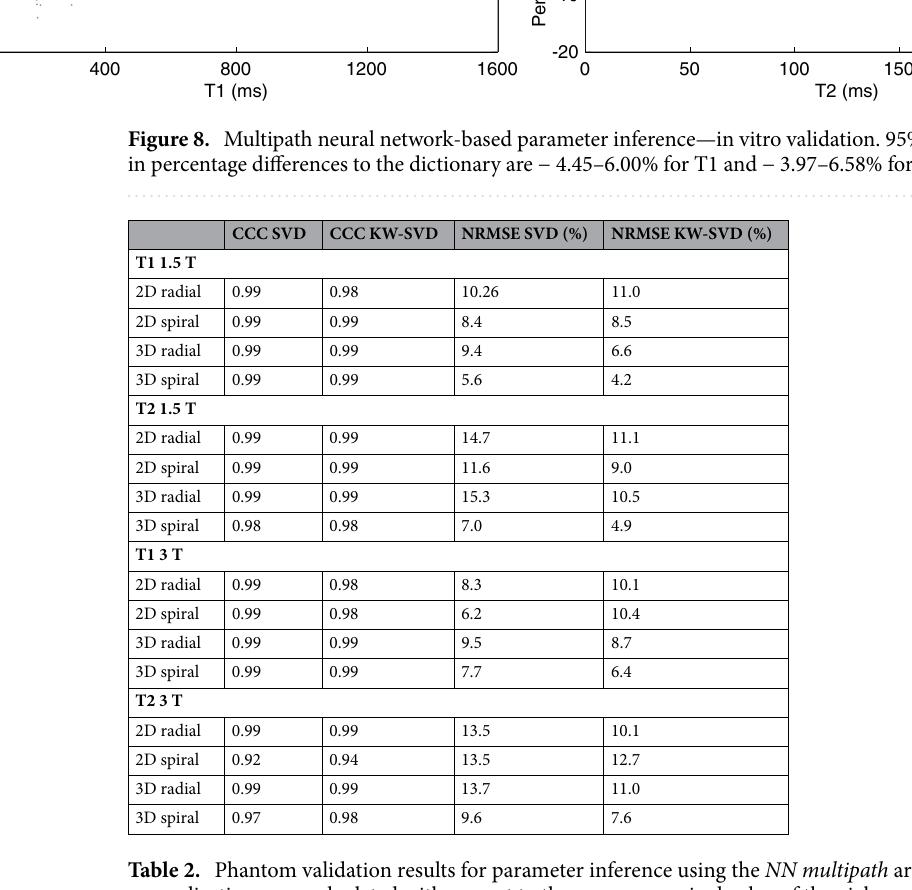
Table 2. Phantom validation results for parameter inference using the NN multipath architecture. NRMSE normalization were calculated with respect to the average nominal value of the vials.